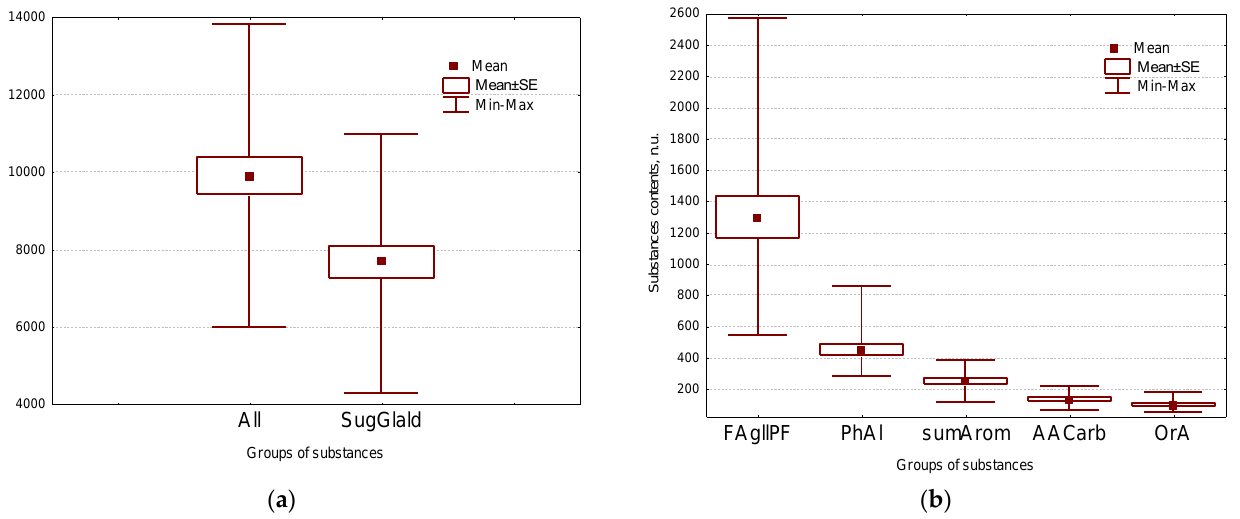
Figure 1. Box-whiskers plots of substances groups’ contents in seeds of all evaluated VIR flax genetic collection lines (in n.u.). ( a ) All substance, total sugars and glyceraldehyde; ( b ) total fatty acids and glycerol, polyhydric alcohols, secondary metabolites, amino acids and carbamide, organic acids and phosphate. Middle point is mean, Box is mean ± standard error, whiskers are min-max intervals.